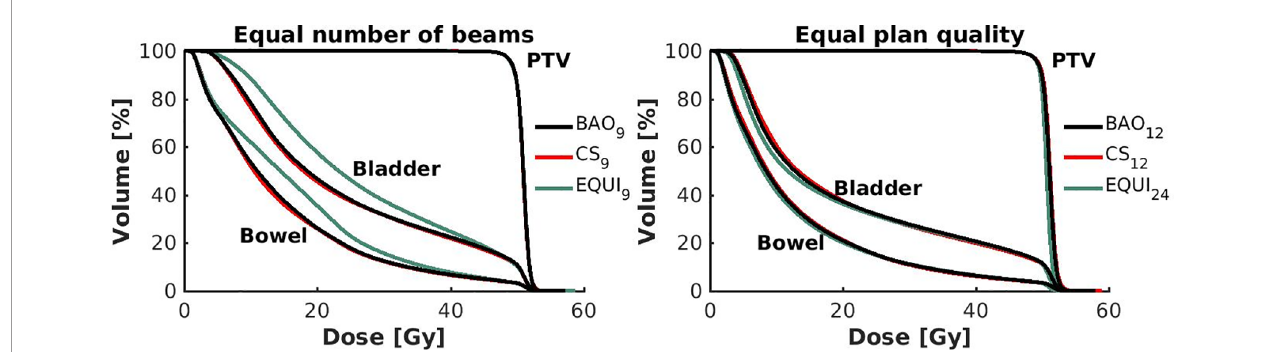
FIGURE 6 | Left: Population mean DVHs for equal numbers of beams, showing higher bowel and bladder doses for equi-angular plans, while BAO and CS almost overlap. Right: Population mean DVHs for similar plan quality, using more beams for equi-angular set-ups (24 instead of